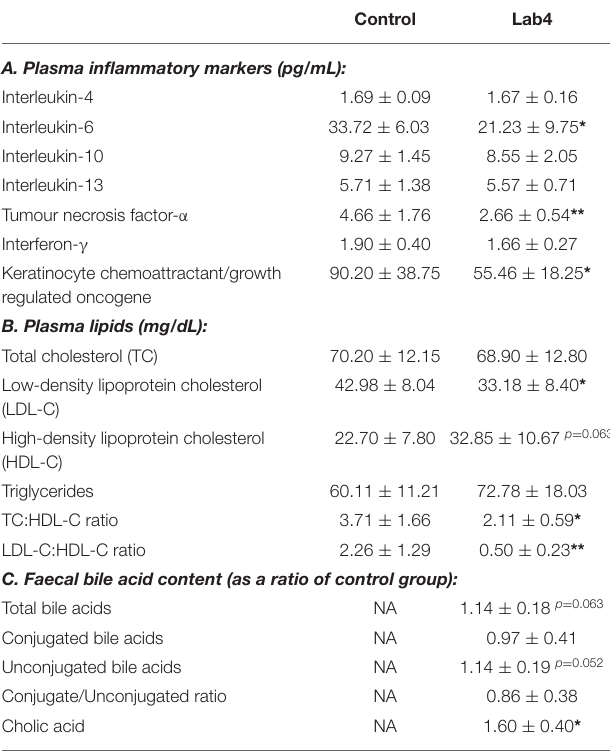
TABLE 1 | Plasma levels of inflammatory markers and lipids and faecal bile acid content in male Wistar rats after 90 days supplementation with